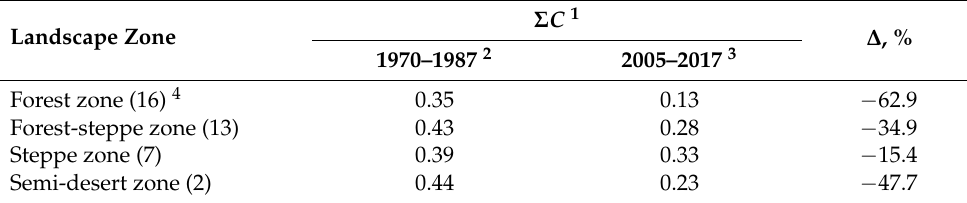
Table 3. Changes in the crop management factor ( C -factor) during the warm season (May to October) in the analyzed landscape zones of European Russia between 1970–1987 and